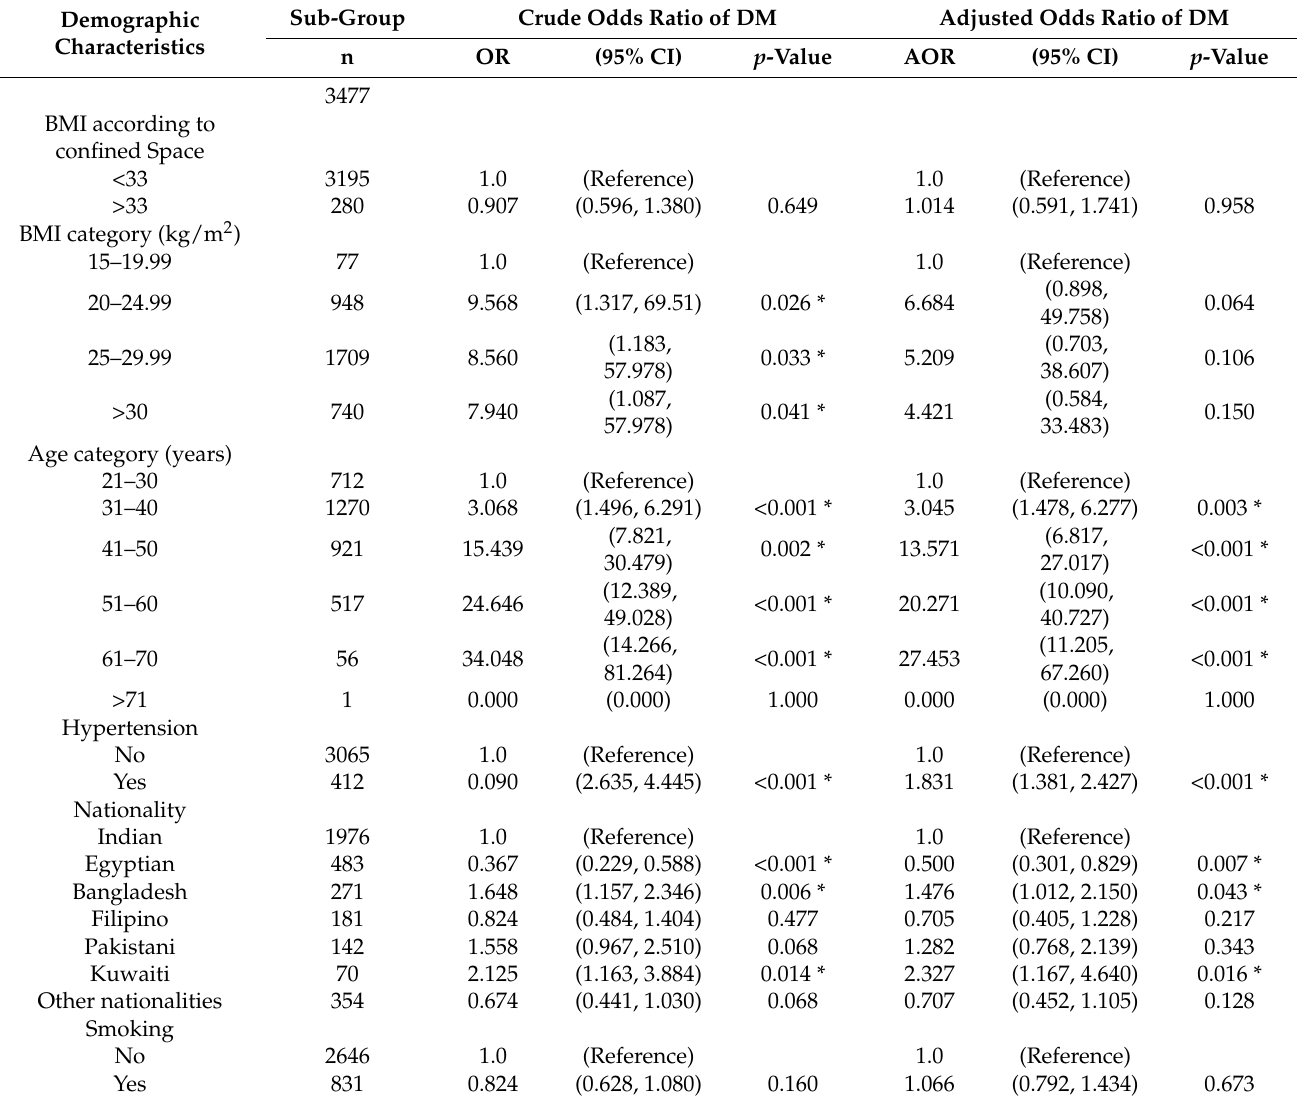
Table 2. Crude and adjusted odds ratios of DM for selected independent variables among workers from SIMC, 2018,